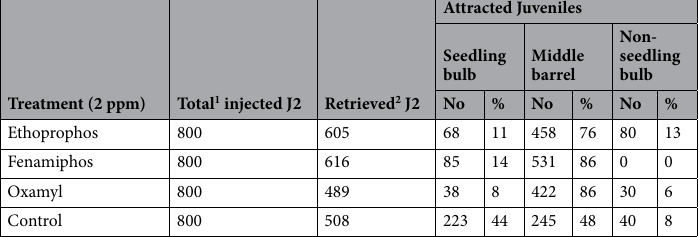
Table 2. Effect of low nematicide concentrations on the orientation of Meloidogyne incognita juveniles to host roots after 72 h. 1 Is the total number of injected Juveniles at 0 times, and 2 is the total number of retrieved Juveniles after 72